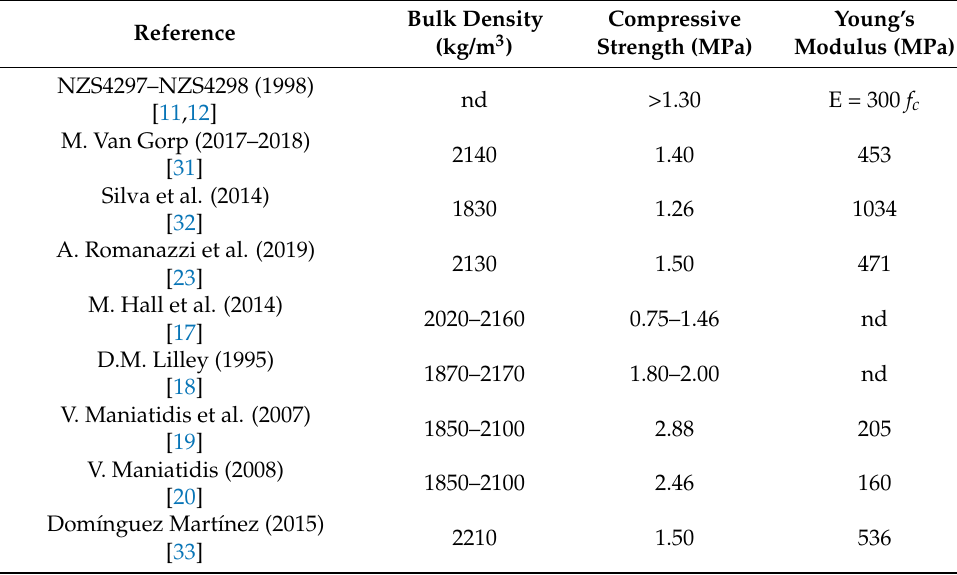
Table 2. Material properties for earth-based mortar from the literature. Bulk Reference